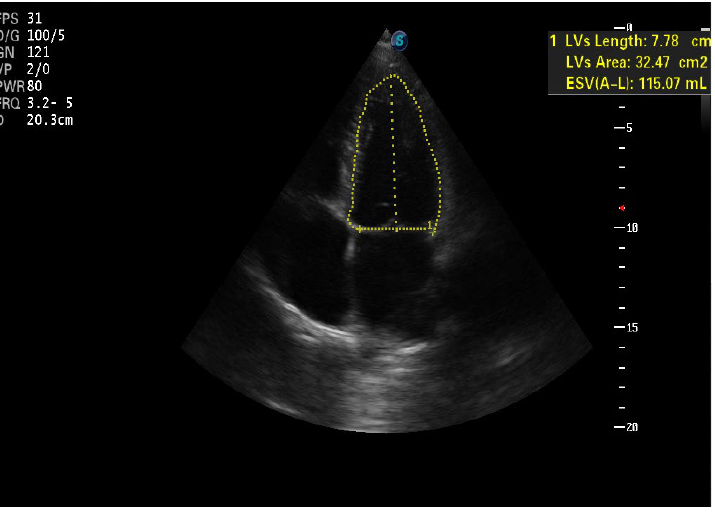
Figure 7. Case 2—TTE showing tele-systolic LV volume evaluation (yellow dotted line) .